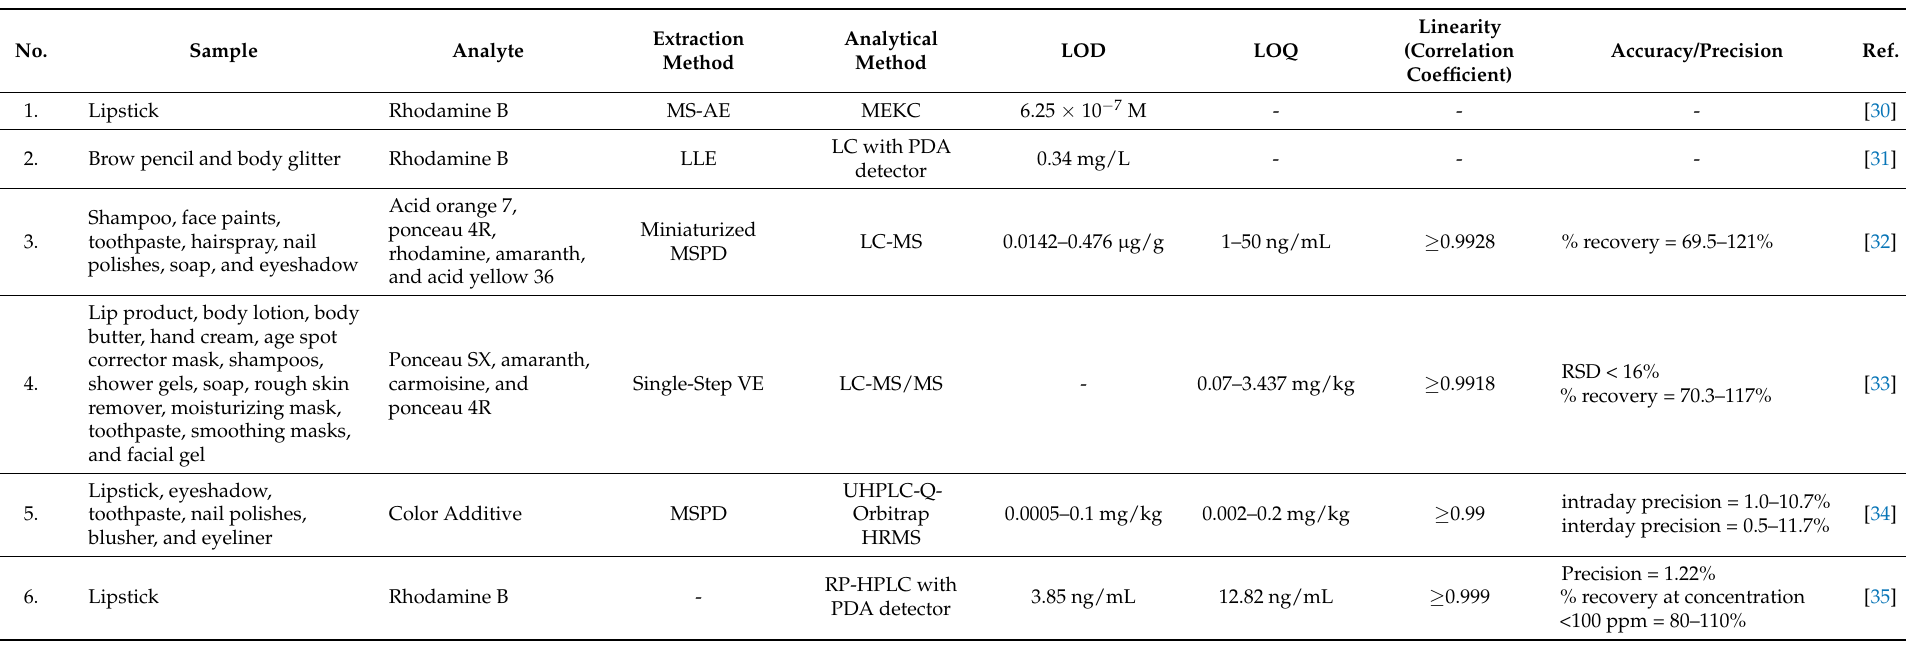
Table 5. Analytical methods for determining restricted and prohibited color additives in